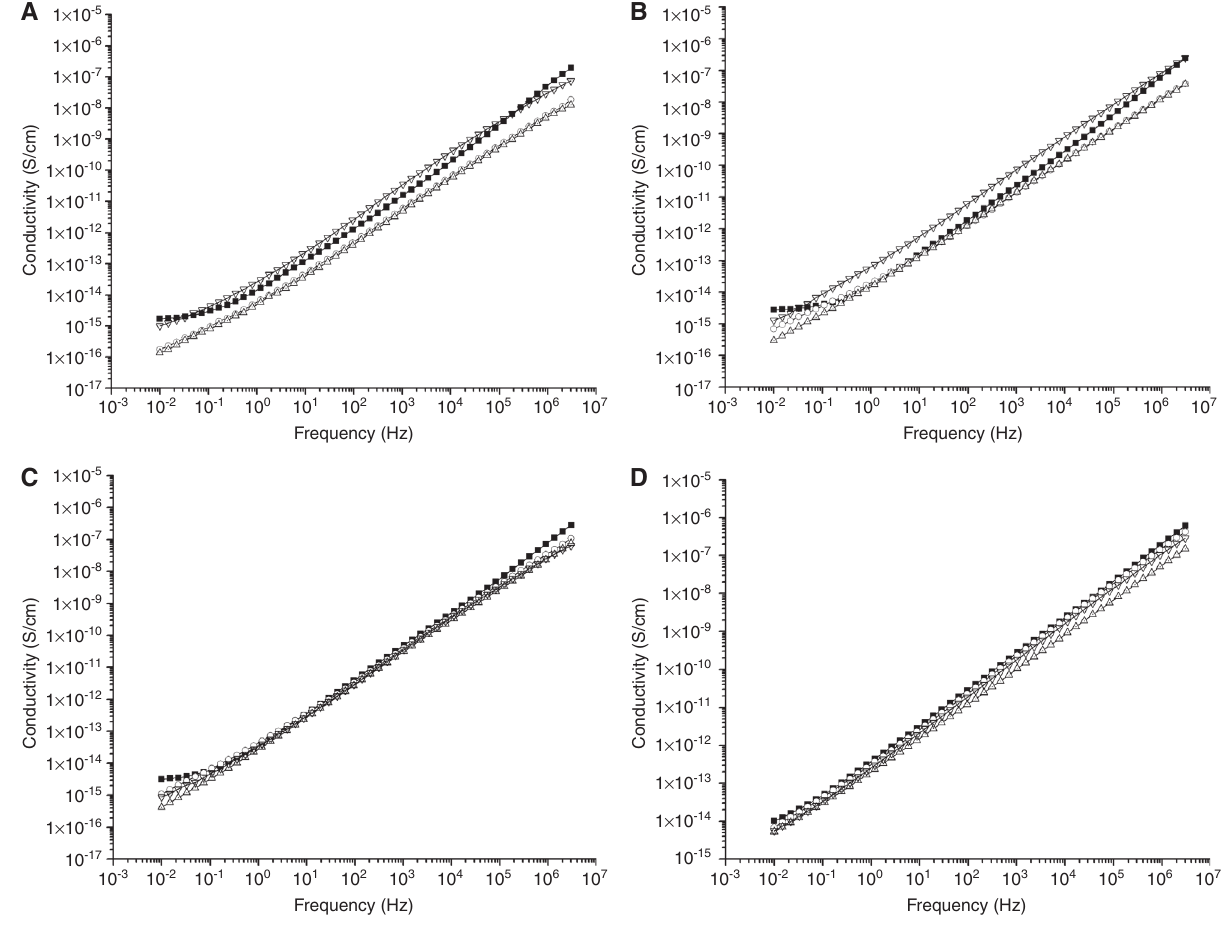
Figure 3 Conductivity ( σ ) at 30 ° C related to the frequency. (A) Compound+5% GTR, (B) compound+10% GTR, (C) compound+20% GTR, and (D) compound+50% GTR: ■, EVA; ○, HDPE; ∆, PP; ,